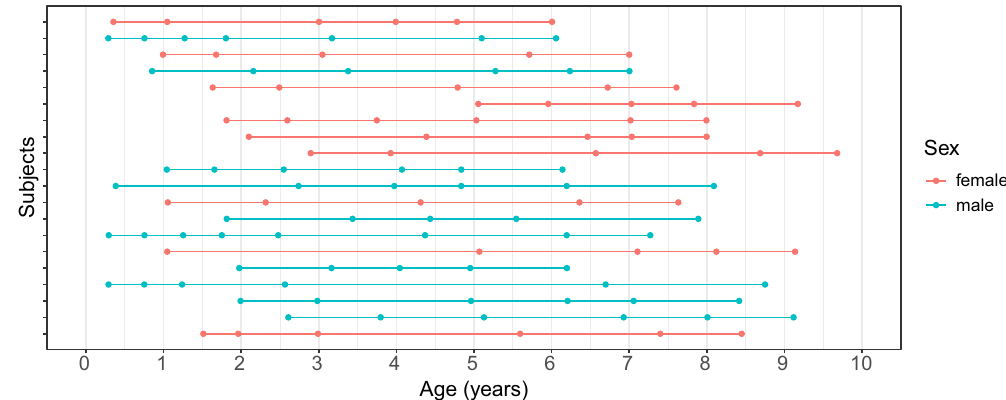
Figure 5. A longitudinal event plot demonstrating the distribution of ages of visits per child for the 10 females and 10 males with the most visits. Each row corresponds to a child, where dots denote the event times where visits took place.